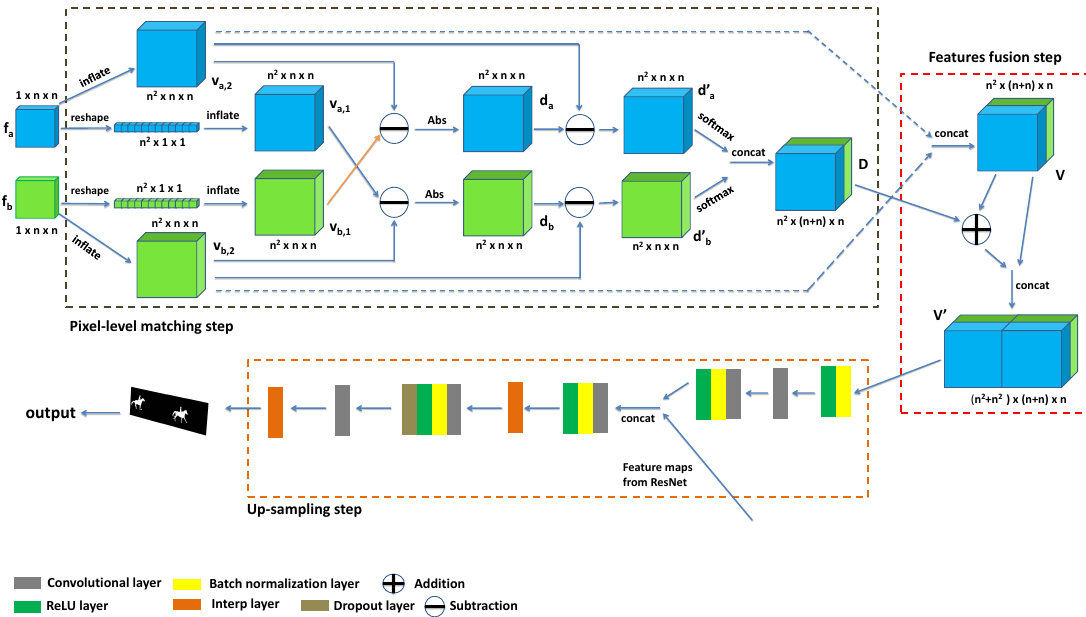
Figure 2. The pipeline of our attention module for pixel-level similarity computation. The module receives a pair of feature maps { f a , f b } containing the foregrounds’ features to generate feature maps v a ,1 , v a ,2 , v b ,1 , and v b ,2 through the reshape and inflation operations. Next, a pixel-level matching step is leveraged to capture the common information from v a ,1 , v a ,2 , v b ,1 , and v b ,2 and generate the feature map D , which is used to fuse with the concatenated feature map V and calculate the high quality dense feature V (cid:48) in the features fusion step. Then, V (cid:48) is fed into the up-sampling step to refine the feature maps from the baseline. Finally, the segmentation result is